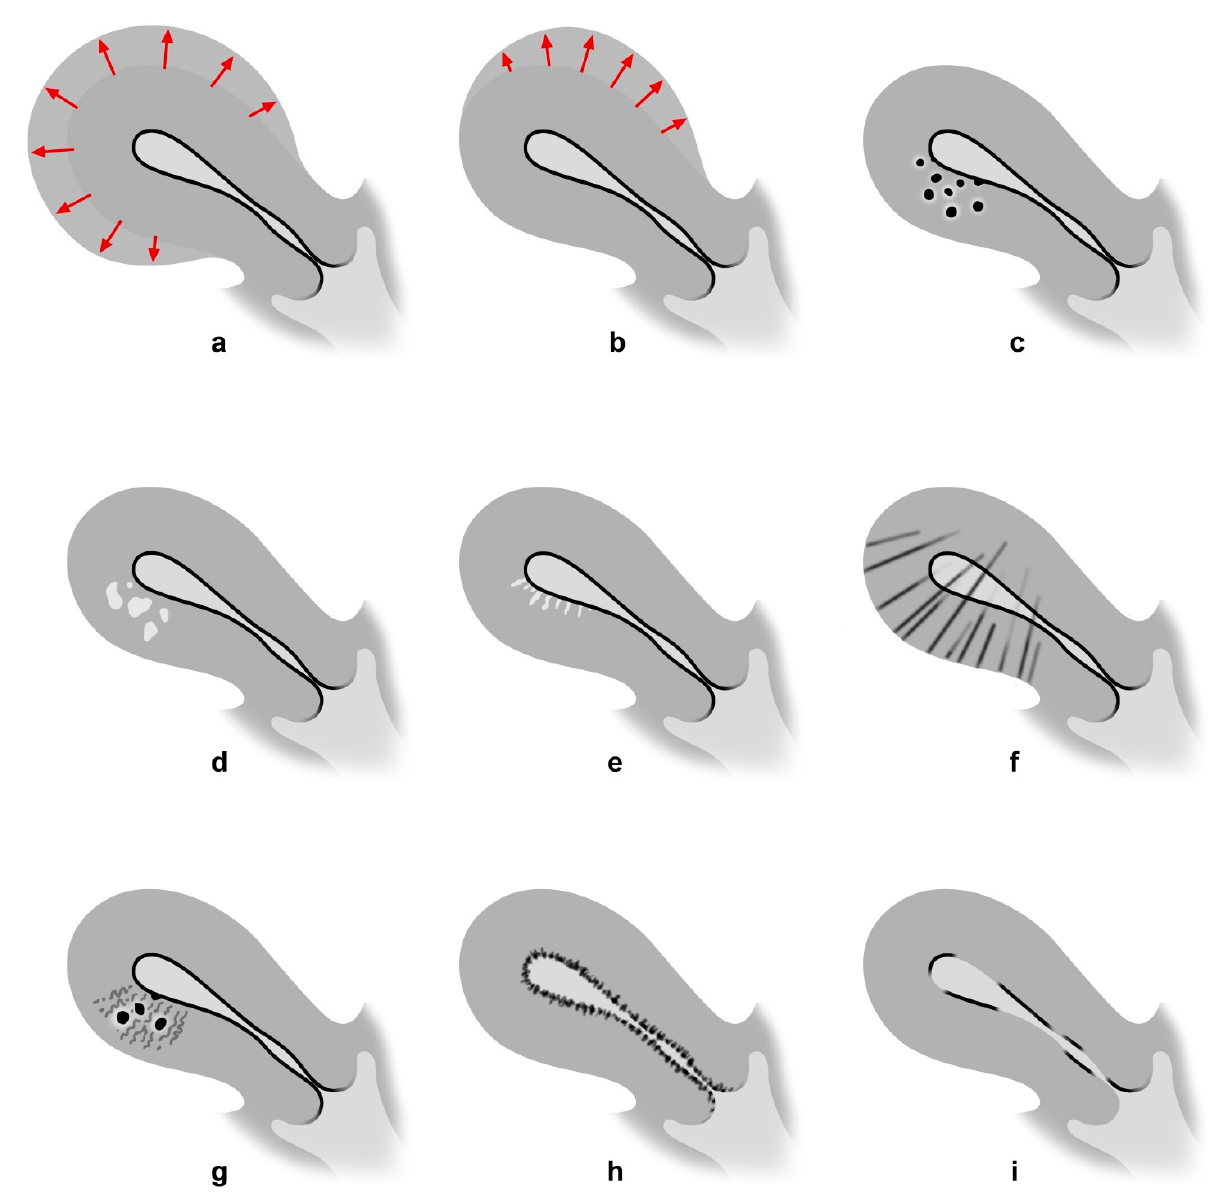
Figure 1. Sonographic findings in adenomyosis [30]. ( a ) Spherical, ( b ) wall difference in favor of the anterior or posterior wall, ( c ) subendometrial cysts, ( d ) echogenic islands, ( e ) fan-shaped shadowing, ( f ) echogenic subendometrial lines or buds, ( g ) translesional vascularity, ( h ) irregular junctional zone, ( i ) interrupted junctional zone.